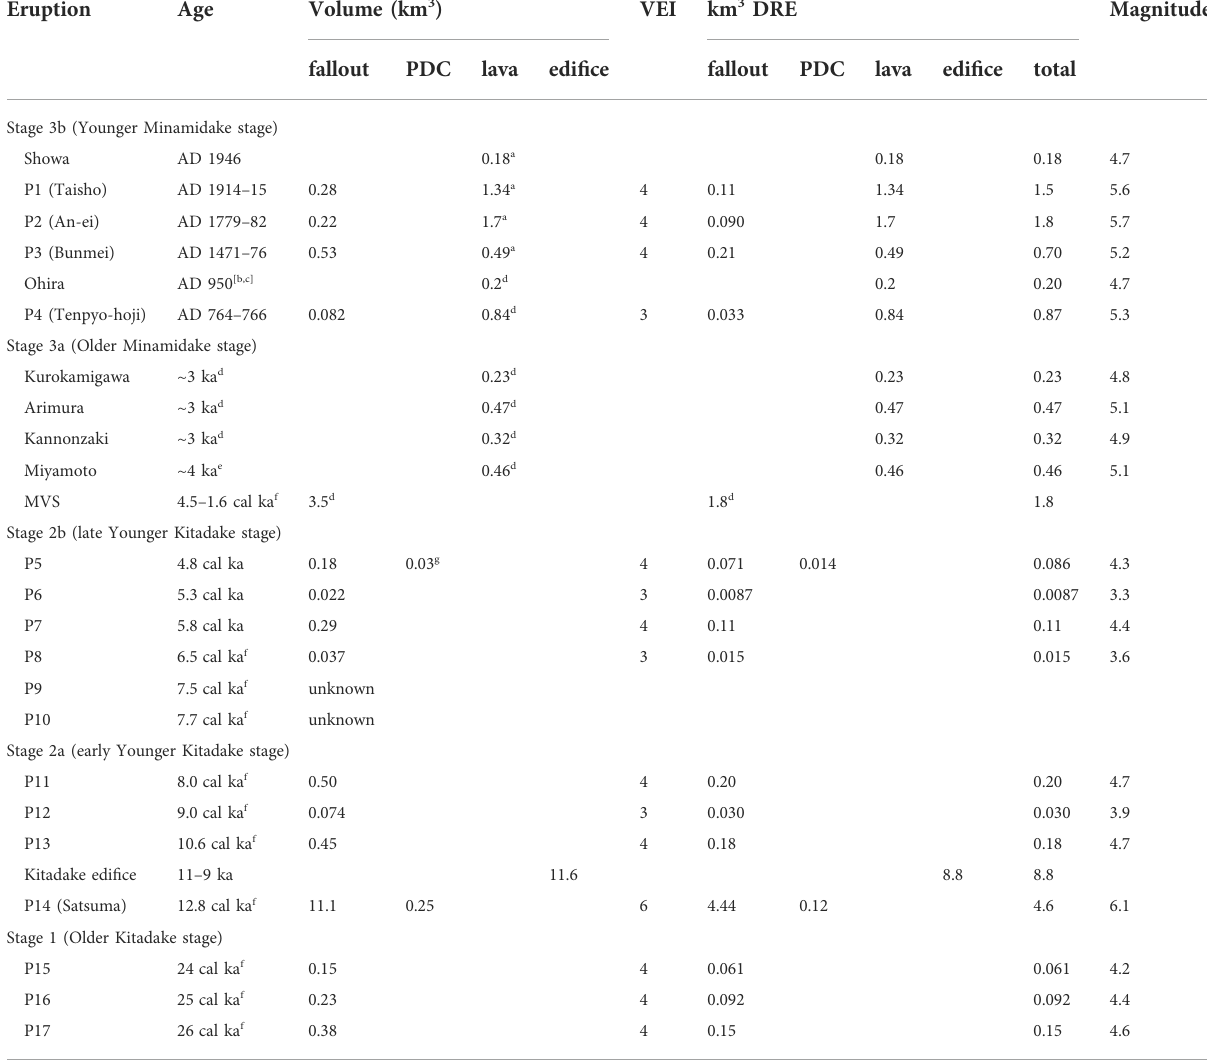
TABLE 4 Summary of the eruptive history of Sakurajima volcano. Volume of lavas (Ishihara et al., 1981; Miki and Kobayashi, 2016) includes both subaerial and submarine distributions. Eruption Age Volume (km 3 )